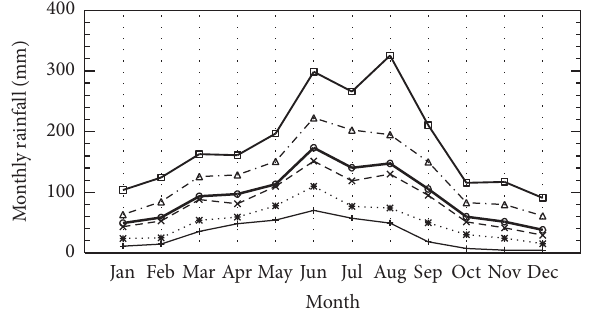
Figure4:Thepercentilesofmonthlyrainfallareplottedas10th(plus solid line), 25th (asterisk dot line), 50th ( × dash line), 75th (triangle dash dot line), and 90th (square solid line). Average monthly rainfall is shown as circle thick solid